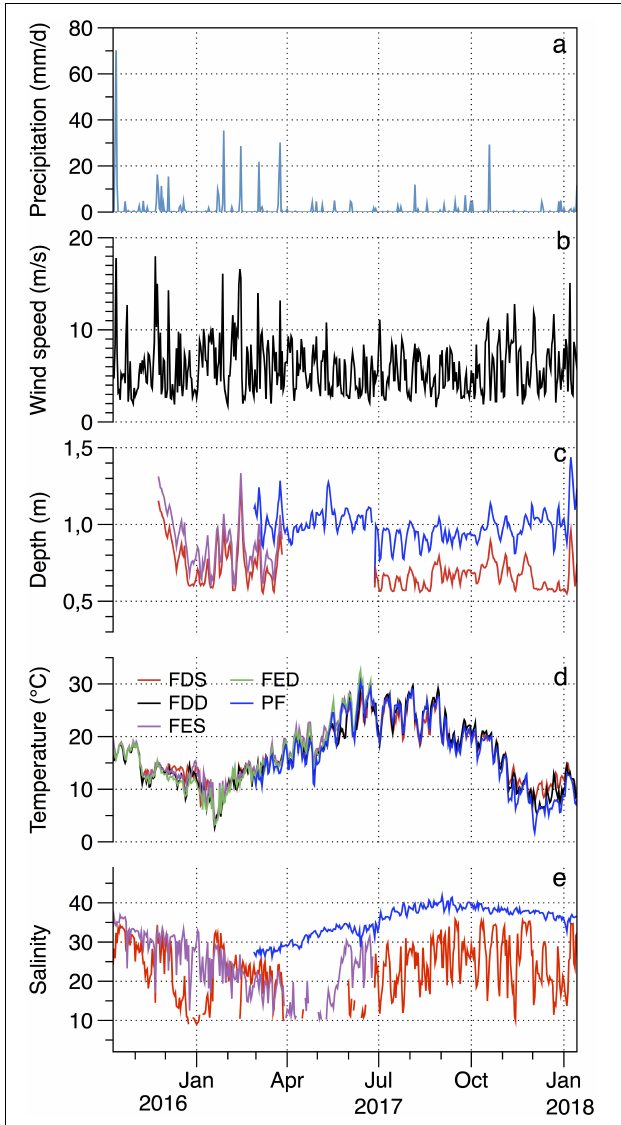
FIGURE 6 | Temporal variations between October 2016 and January 2018 in (a) precipitation, (b) wind speed, (c) water depth, (d) temperature, and (e) salinity in Salses-Leucate lagoon: Font Dame Surface (FDS), Font Dame Deep (FDD), Font Estramar Surface (FES), Font Estramar Deep (FED), and Port Fitou (PF). The salinity data shows large variability and presents similar seasonal pattern for surface and bottom cages. For clarity, we present the surface water salinity